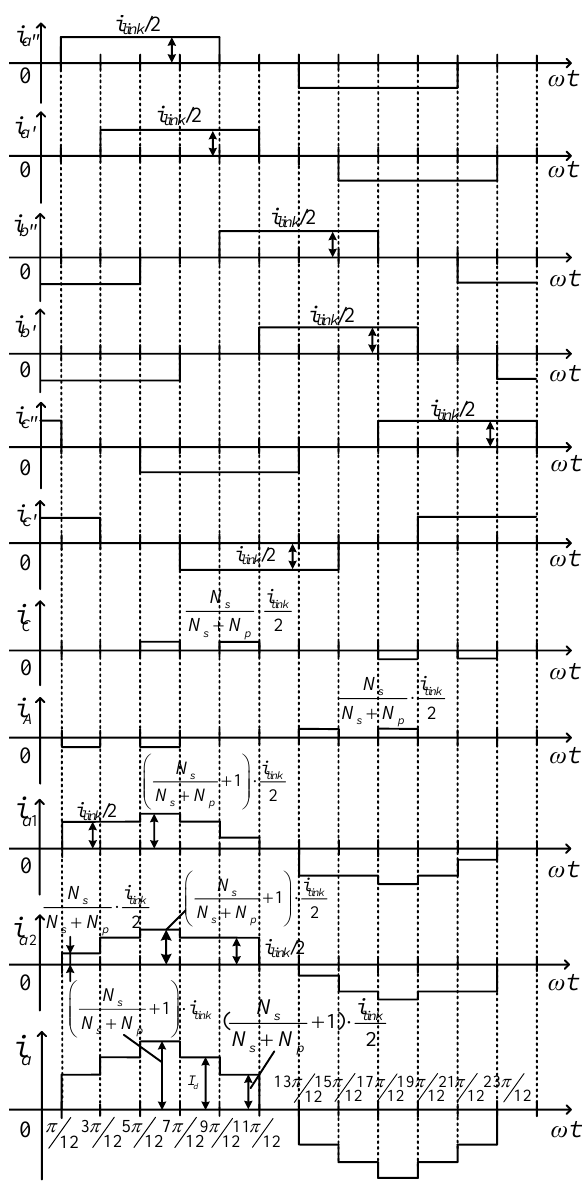
Figure 4. Current waveforms of the studied 12-pulse auto-transformer rectifier unit (ATRU).